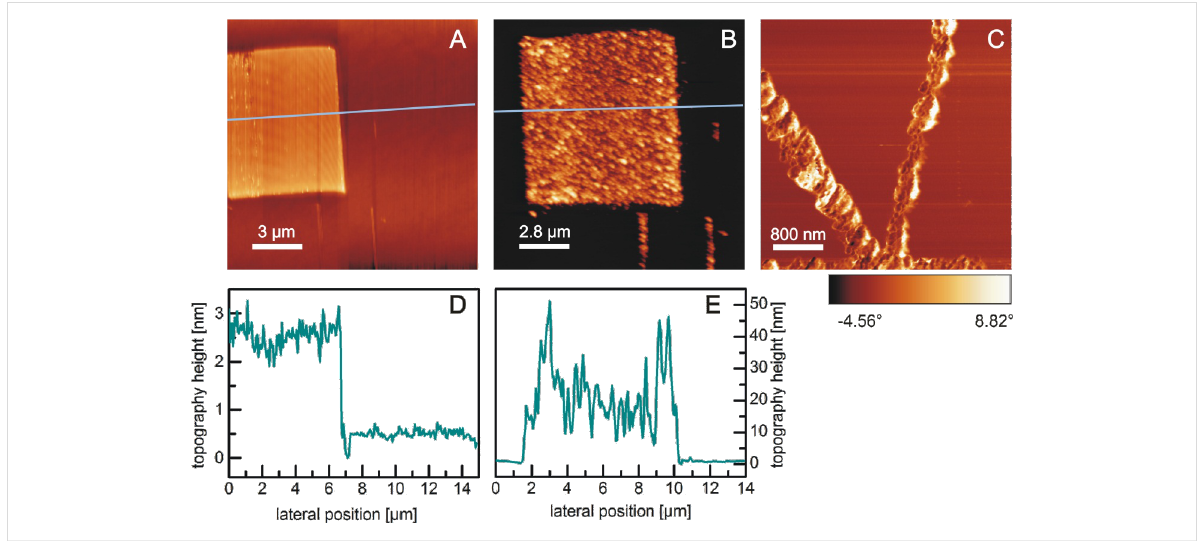
Figure 2: AFM height images of LAO oxide structures before (A) and after (B) 40 h in a 10 mM OTS solution in toluene under ambient conditions. (C) AFM phase image of line structures after 40 h in OTS. (D, E) topography profiles along the lines in A and B.